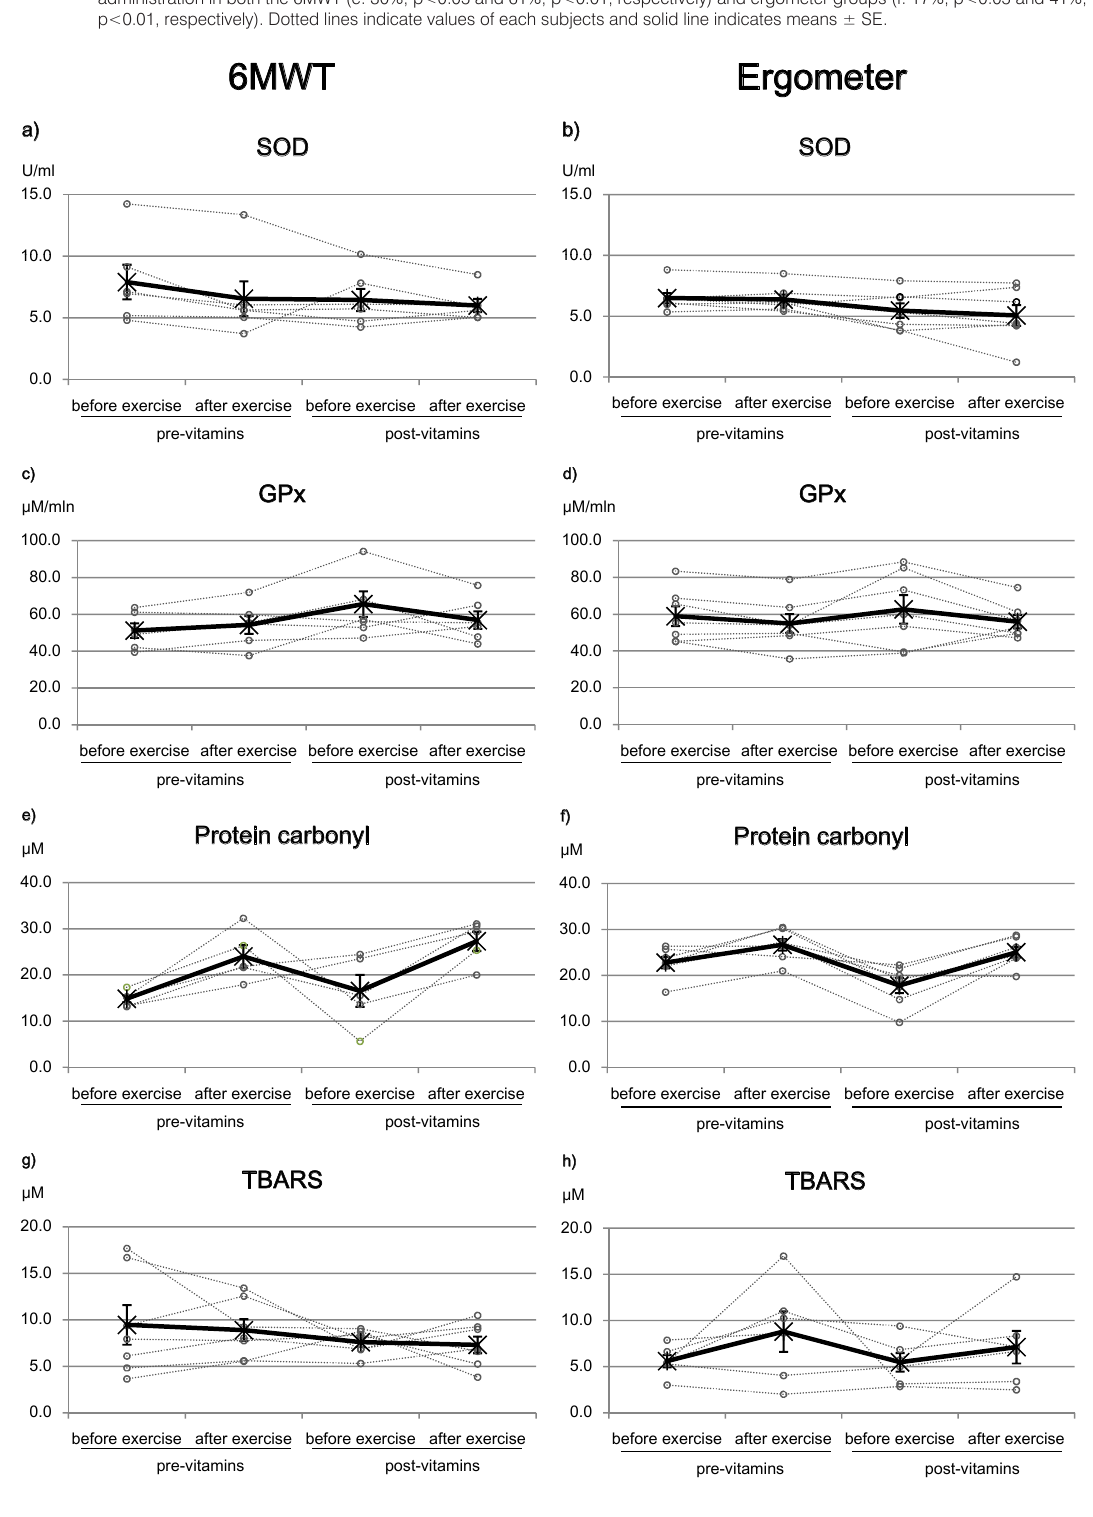
Figure 4. Plasma superoxide dismutase (SOD) activity, glutathione peroxidase (GPx) activity, protein carbonyl and thiobarbituric acid-reactive substance (TBARS) in the 6-min walk test (6MWT) and cycle ergometer groups. In the 6MWT group, SOD decreased significantly after exercise pre-vitamin administration (a: p<0.05). Protein carbonyl content increased significantly after exercise both pre- and post-vitamin administration in both the 6MWT (e: 30%; p<0.05 and 61%; p<0.01, respectively) and ergometer groups (f: 17%; p<0.05 and 41%; p<0.01, respectively). Dotted lines indicate values of each subjects and solid line indicates means ±